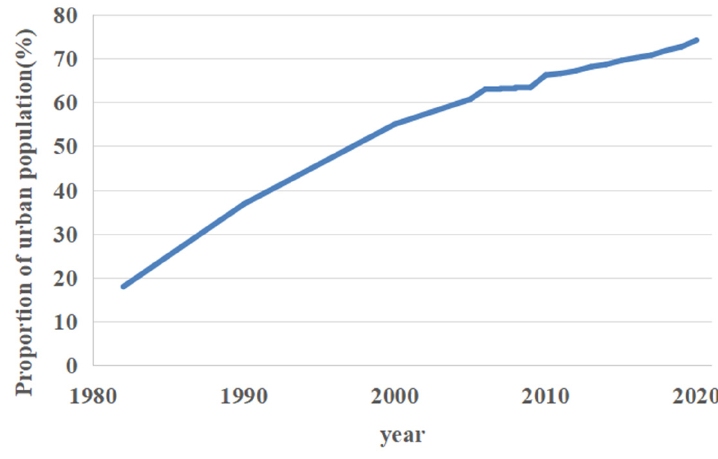
Figure 6. Changes in the proportion of urban population in Guangdong Province.